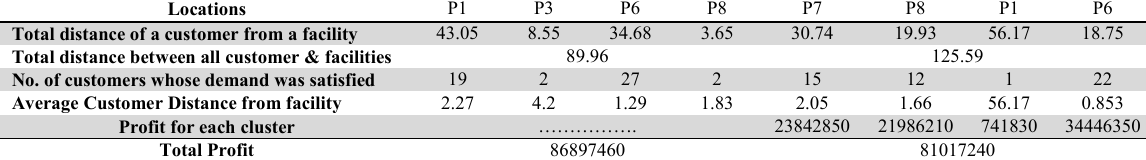
Table 3(c) Number of clusters =